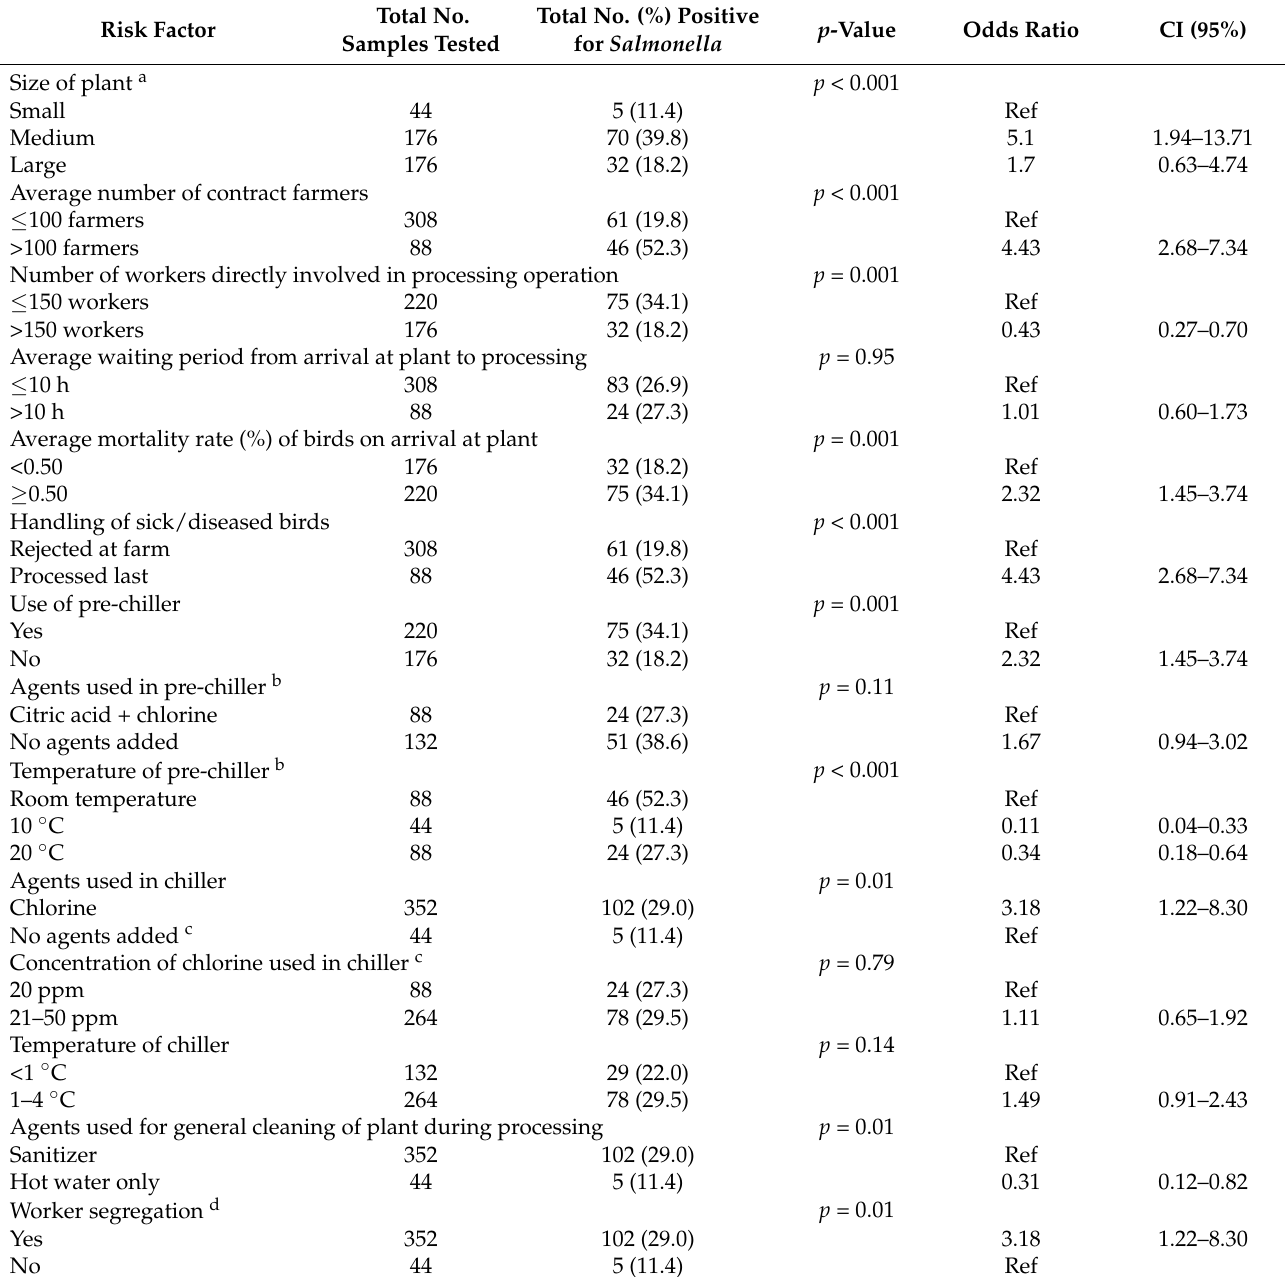
Table 2. Risk factors associated with Salmonella contamination of